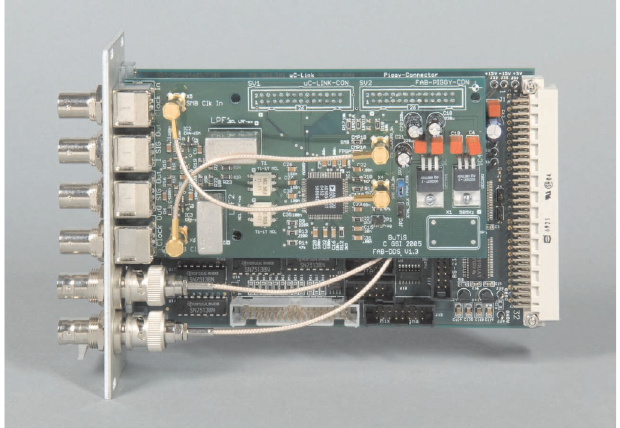
FIG. 6. DDS unit (piggy-back DDS board on